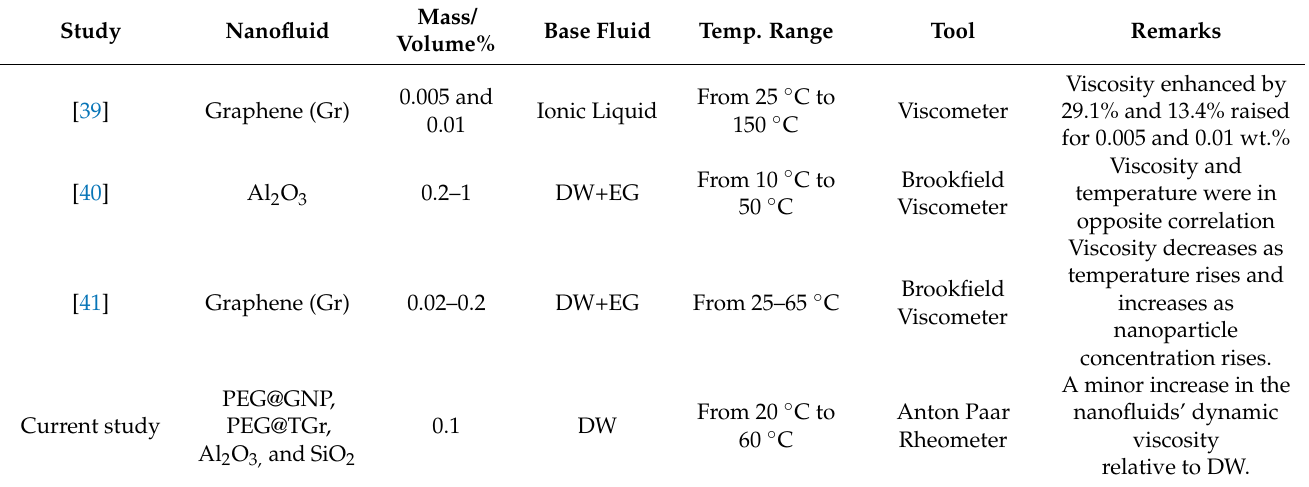
Table 3. Summary of viscosity in previous experimental